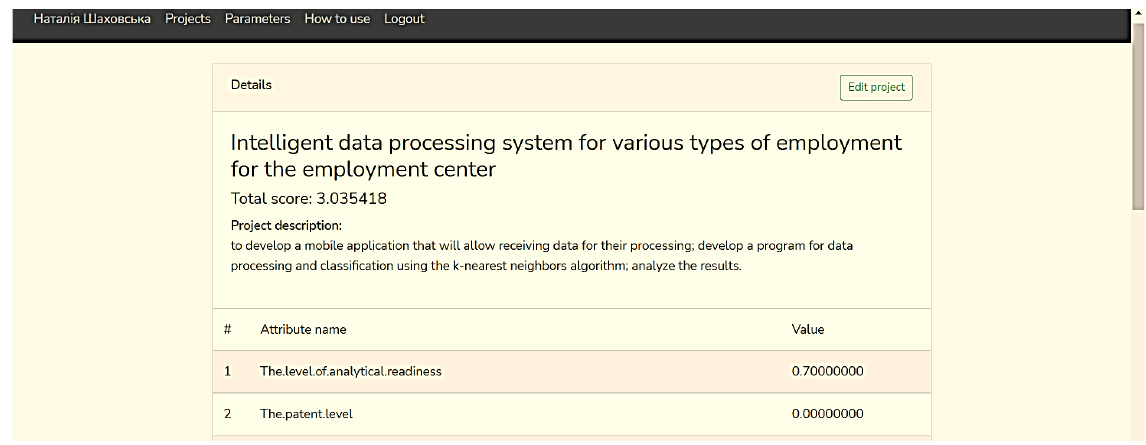
Figure 9. Webpage for new R&D product adding.